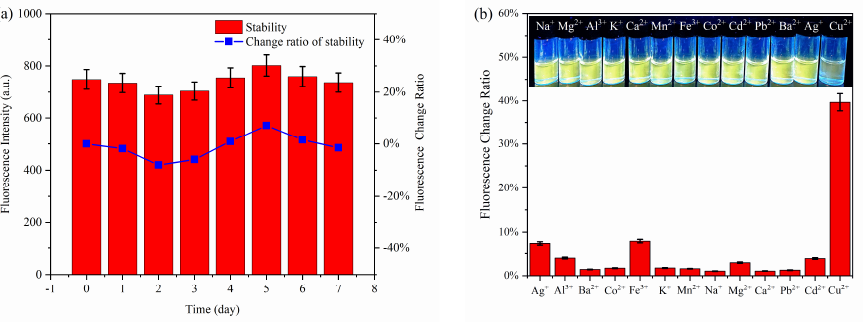
Figure 6. The stability ( a ) and the selectivity ( b ) of the fluorescent